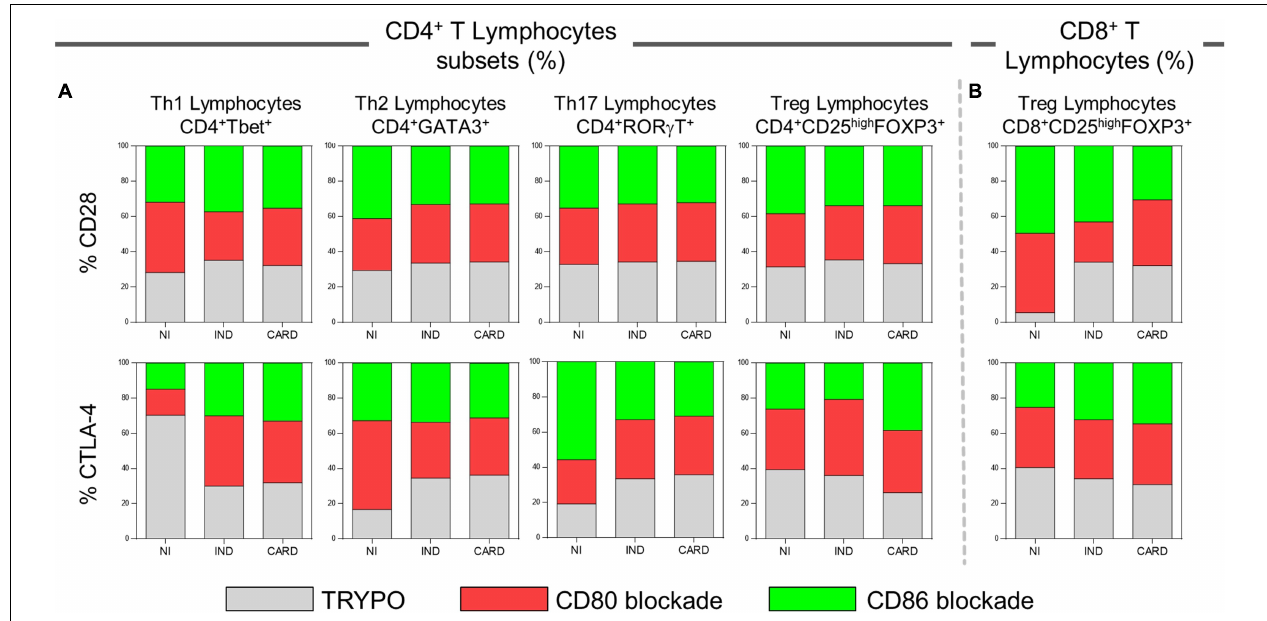
FIGURE 5 | Proportion of CD28 and CTLA-4 expression by lymphocyte subsets. Proportion of CD28 and CTLA-4 ligands on Th1, Th2, Th17, CD4 + Treg (A) , and CD8 + Treg lymphocytes (B) in PBMC cultures with TRYPO, with anti-CD80 antibody blockade, and with anti-CD86 antibody blockade from NI individuals ( n = 9), indeterminate (IND, n = 9), and cardiac (CARD, n = 11) clinical forms of Chagas